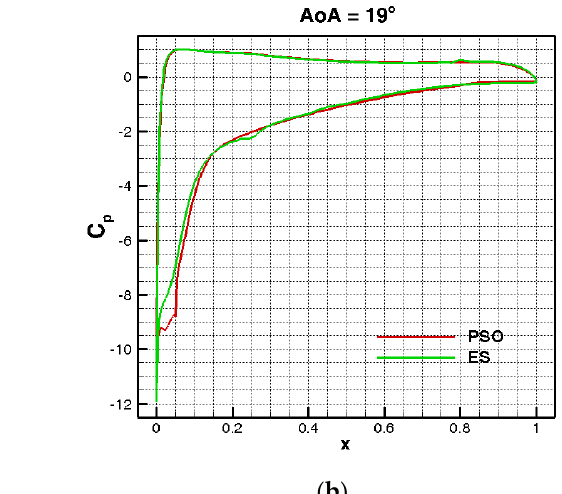
Table 7. Comparison of aerodynamic characteristics at the C L,max angle of attack. Lift, drag, angle of attack, and aerodynamic performance are presented for the initial NACA 64A010 and the morphed PSO and ES airfoils. Airfoil